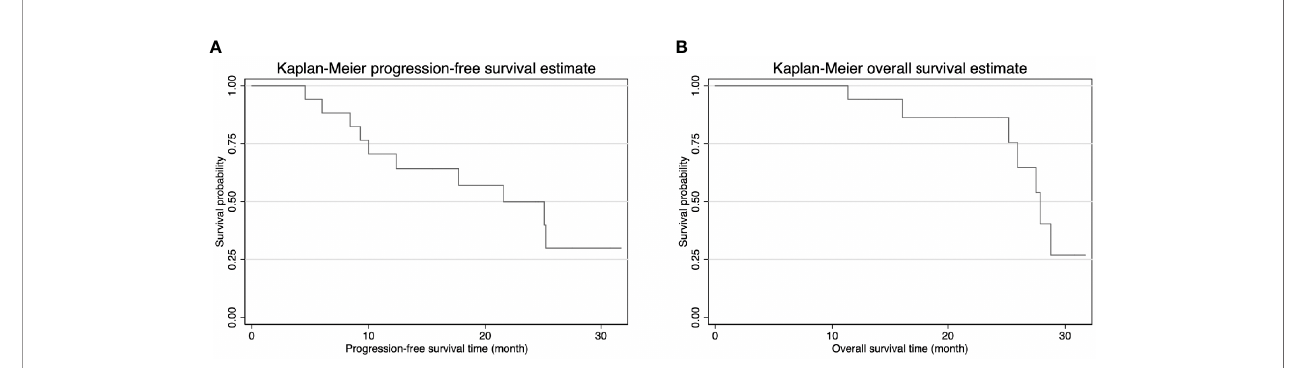
FIGURE 5 | (A) Kaplan-Meier progression-free survival (PFS) curve showed median PFS was 21.5 months. (B) Kaplan-Meier overall survival curve (OS) curve showed median OS was 27.9